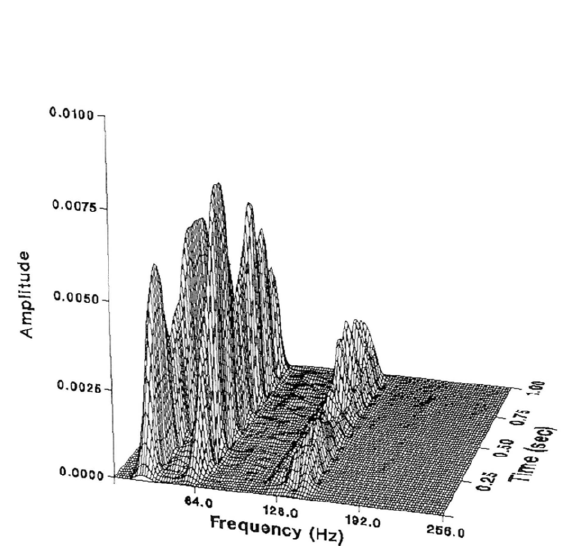
FIGURE 10 Pseudo Wigner-Ville distribution of the actual fan. Is = 512 Hz, N = 512, smoothing window size = 13 x 13.